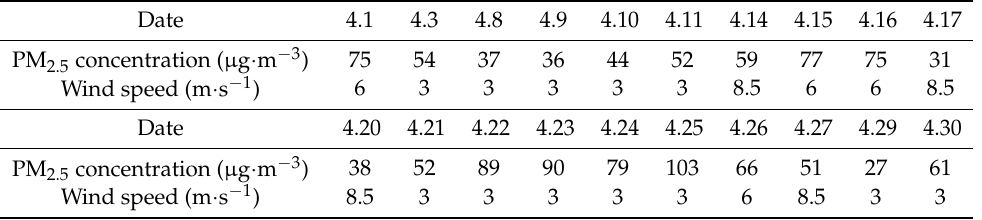
Table 7. PM 2.5 concentrations and wind speeds of Nantong in April